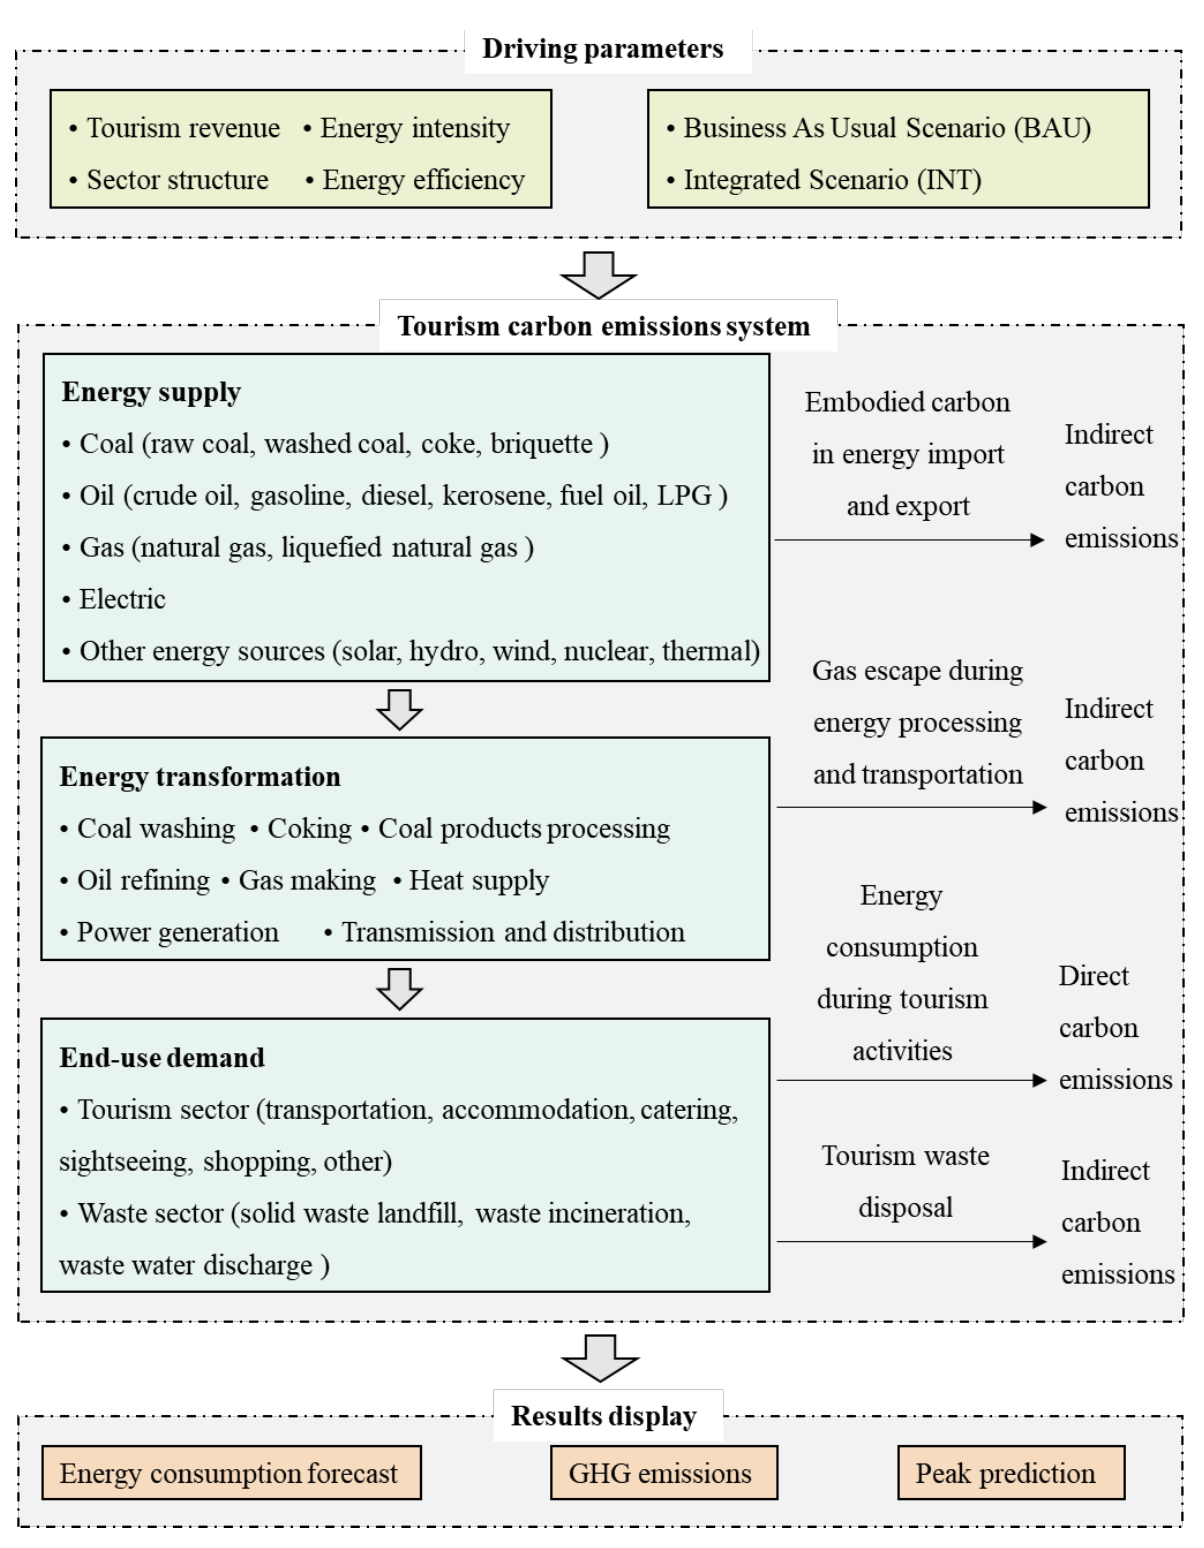
Figure 1. Research flowchart according to the long-range energy alternatives planning system (LEAP)-Tourist model.